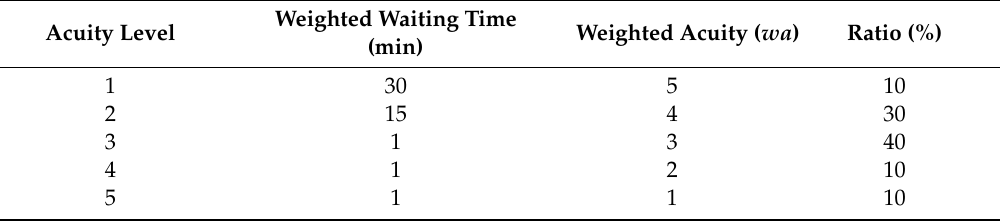
Table 4. Weighted waiting time, weight acuity, and ratio of